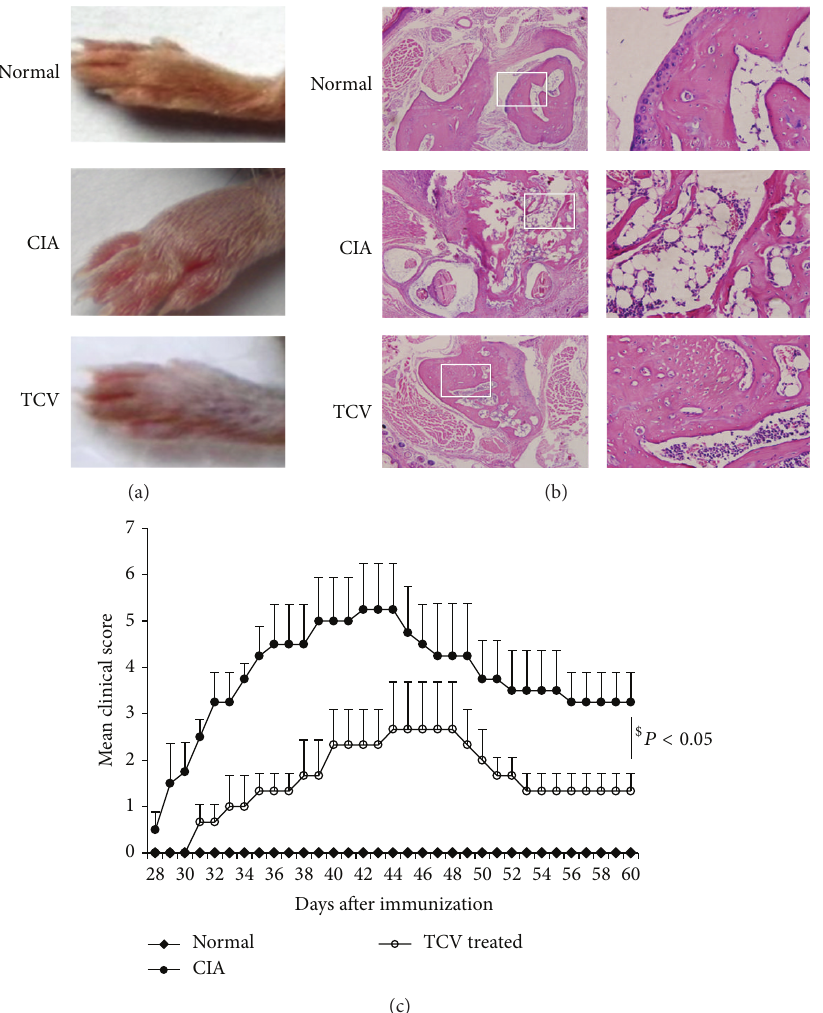
Figure 1: Clinical assessment of CIA and histopathological analysis of joints. The three experimental groups included normal, CIA, and TCV- treated groups. The TCV-treated group was immunized with 1 × 10 7 irradiated T cells two weeks before the establishment of CIA. The CIA group was injected with PBS as a control. (a) Appearance of relevant paws. (b) Histopathological changes of joints. (HE, left × 100, right × 400). (c) Clinical scores were assessed. Data are represented as means ± SD ( 𝑛 = 10 mice/group). Data are representative of 5 separate experiments with similar results. $ 𝑃 < 0.05 , TCV versus CIA